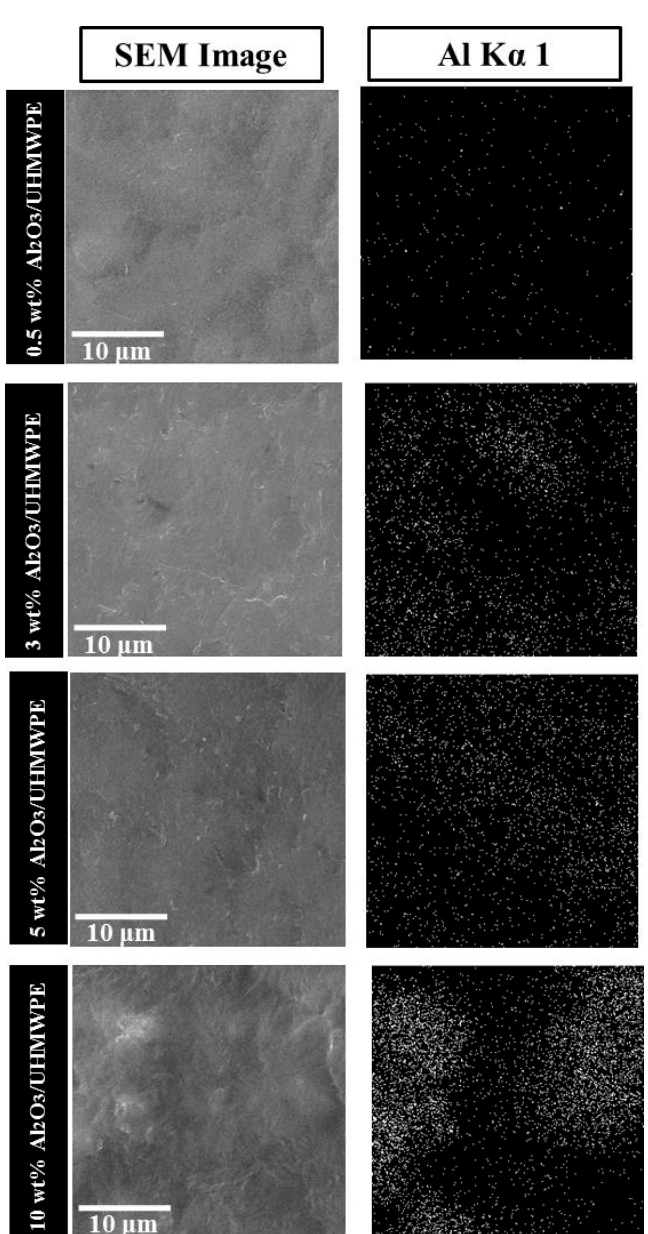
Figure 4. FESEM and EDS (Al) elemental mapping images for the nanocomposite coatings with different loadings (0.5, 3, 5, and 10 wt %) of alumina.